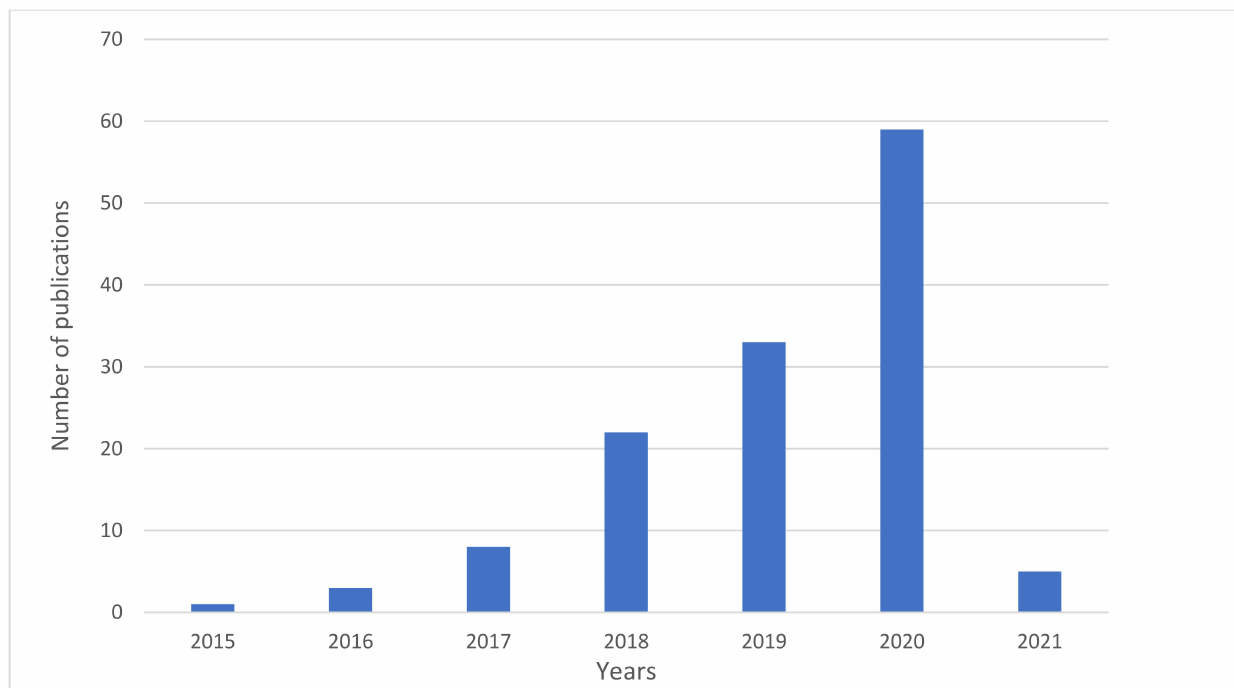
Figure 2. Temporal analysis of the selected